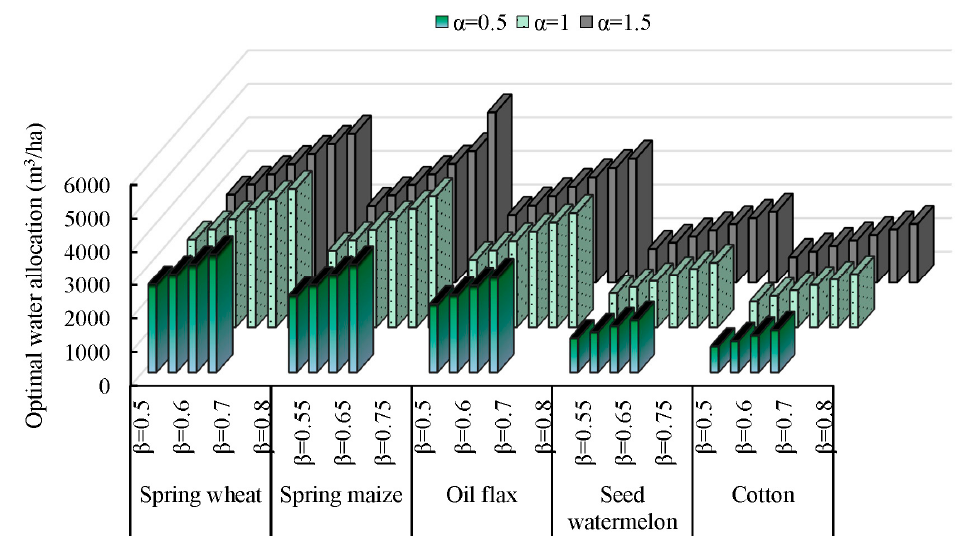
Figure 4. Optimal water resources allocation amounts for different crops under different scenarios.